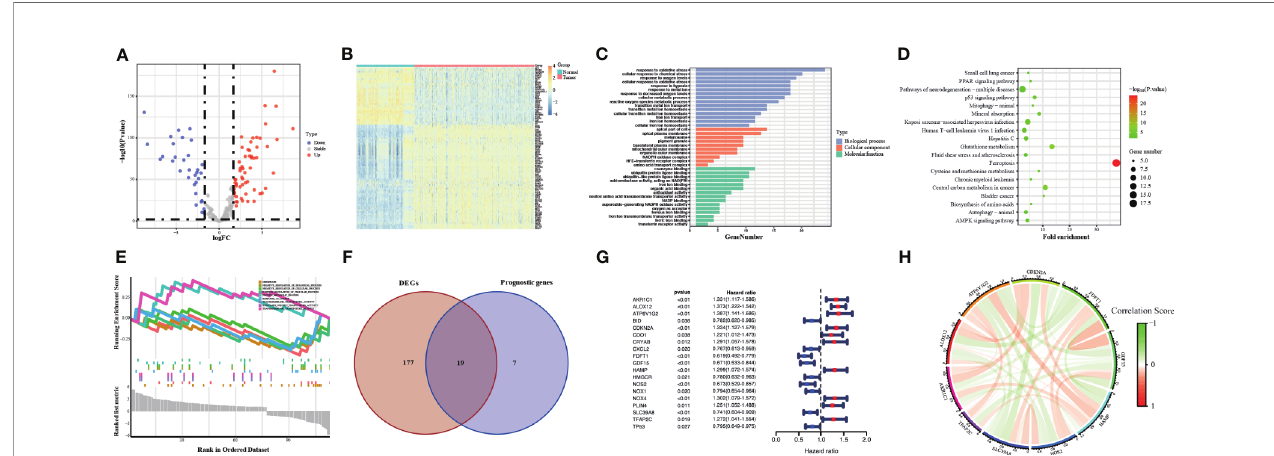
FIGURE 2 | Volcano map (A) and Heatmap (B) of the ferroptosis DEGs in normal and tumor tissues from the GTEx and TCGA datasets. GO (C) , KEGG (D) and GSEA (E) analyses of the ferroptosis DEGs. Venn plot (F) to identify the DEGs that were correlated with OS. Forest plot (G) to show the results of the univariate cox regression analysis between DEGs expression and prognosis. The correlation network plot (H) of the 10